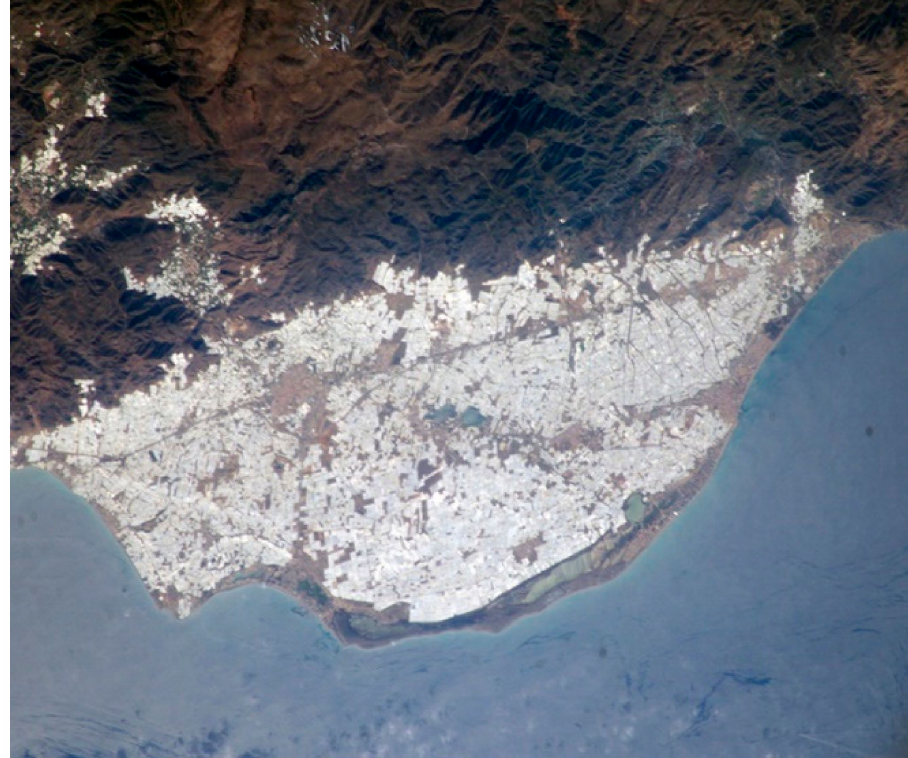
Figure 2. Sea of